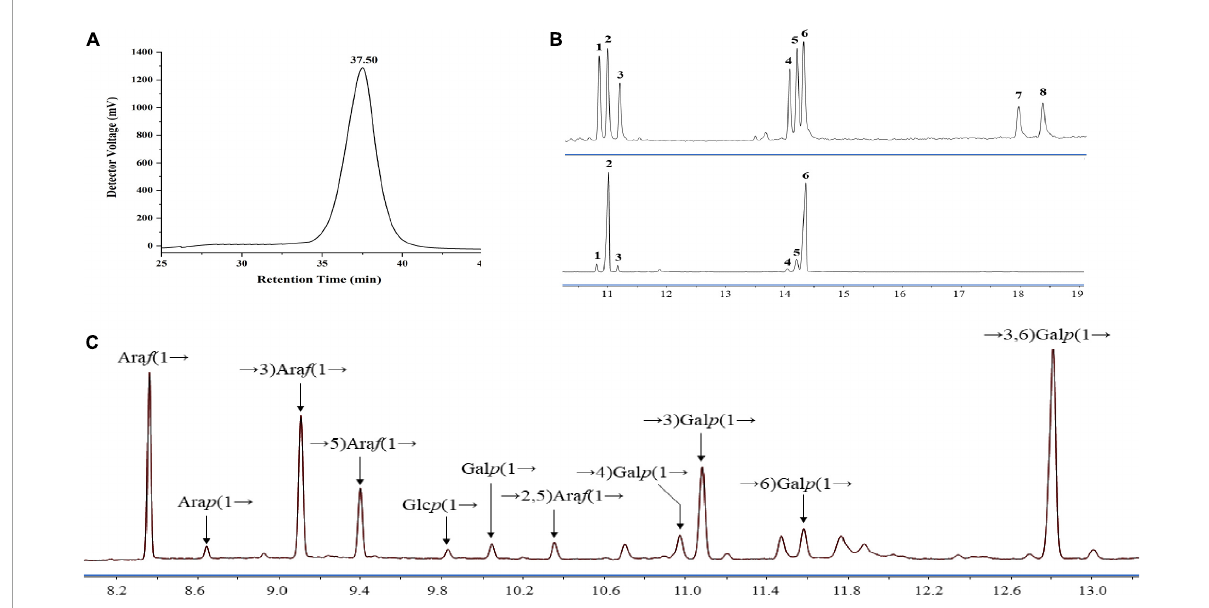
FIGURE1 Homogeneity and composition of LFP-80-W1. (A) HPGPC spectra; (B) mixed standard monosaccharides (upper) and LFP-80-W1 (lower) peak: (1) Rha, (2) Ara, (3) Xyl, (4) Man, (5) Glc, (6) Gal (7) GlcA, and (8) GalA. (C) Methylation analysis of LFP-80-W1 and the source data were provided in Supplementary Figure 3 for the identification of each target peak.